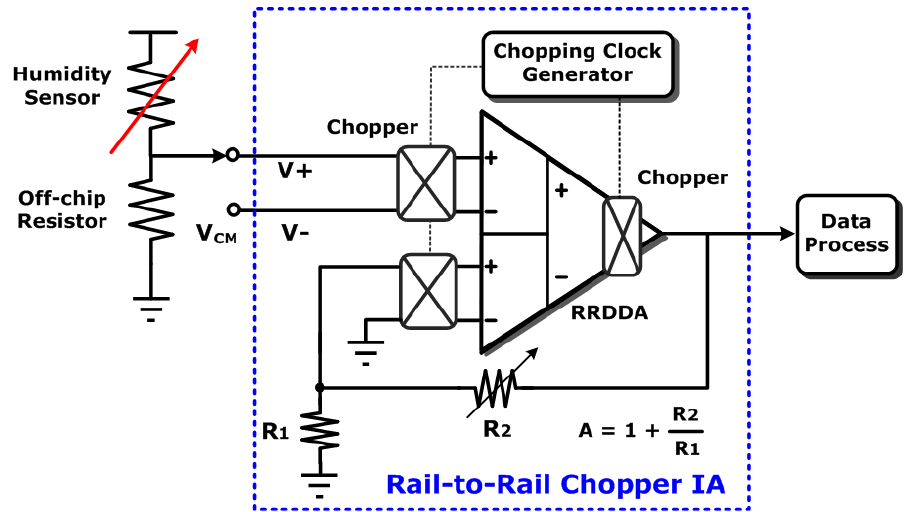
Figure 2. The schematic of analog front-end (AFE) readout